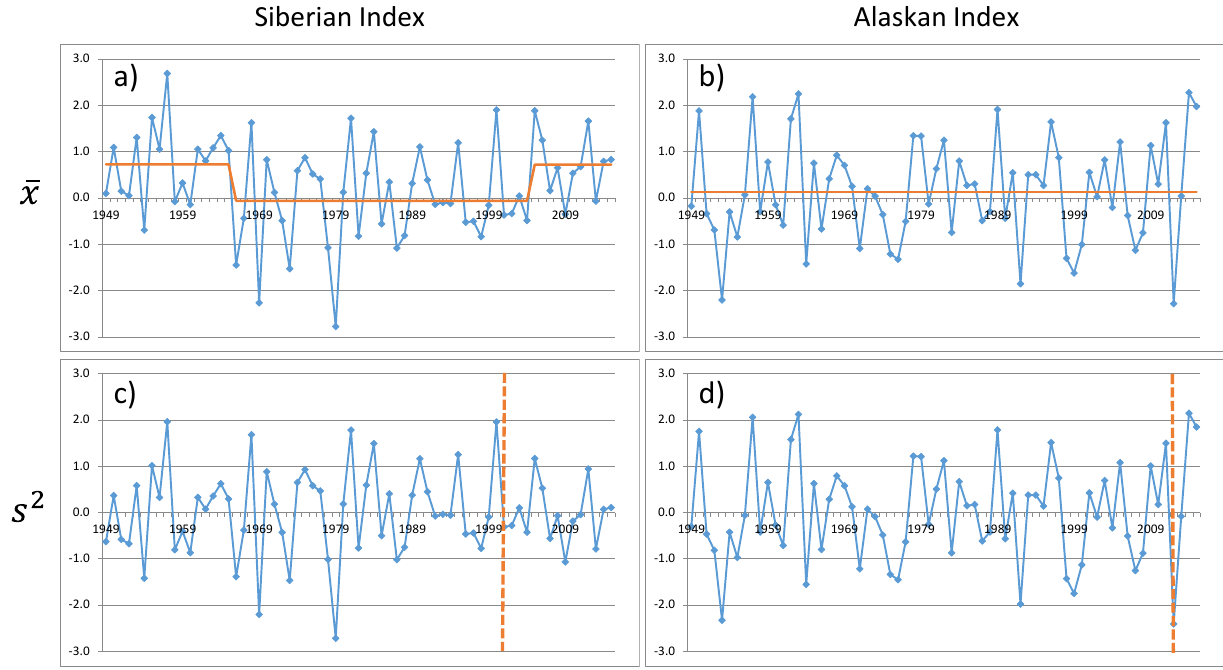
Figure 8. Regime shifts in the mean (top row) and variance (bottom row) for the Siberian (left column) and Alaskan (right column) indices. In all four cases, the target significance level and cut-off length were set at 0.1 and 15, respectively. The change-points and their 𝑝 -values (in parentheses) are: ( a ) 1966 (0.003), 2005 (0.006); ( b ) none detected; ( c ) 2001 (0.04); and ( d ) 2012 (not calculated due to a small number of points after the